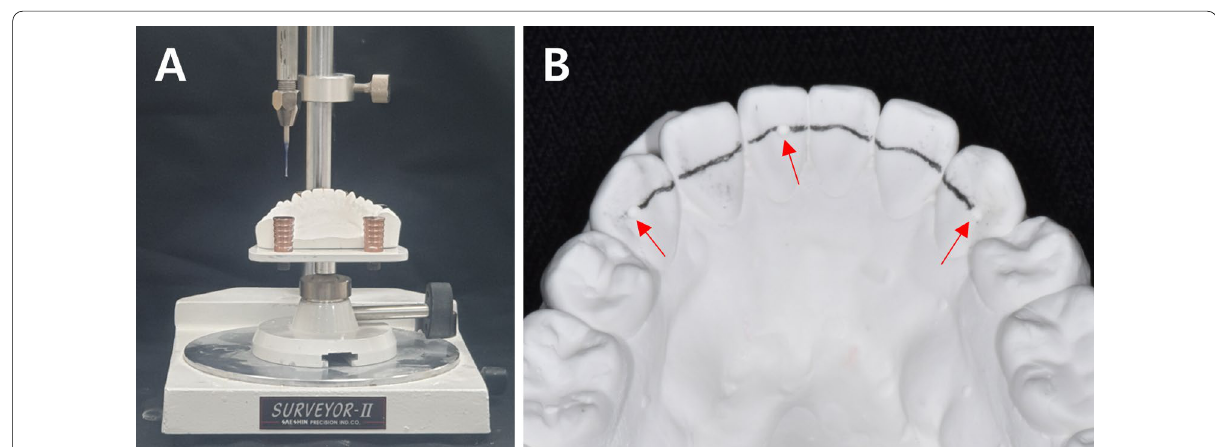
Fig. 2 Design of lingual fixed retainer. A Design on one plane using dental surveyor. B After formation of small dimples (arrows) on two canines and one central incisor using round